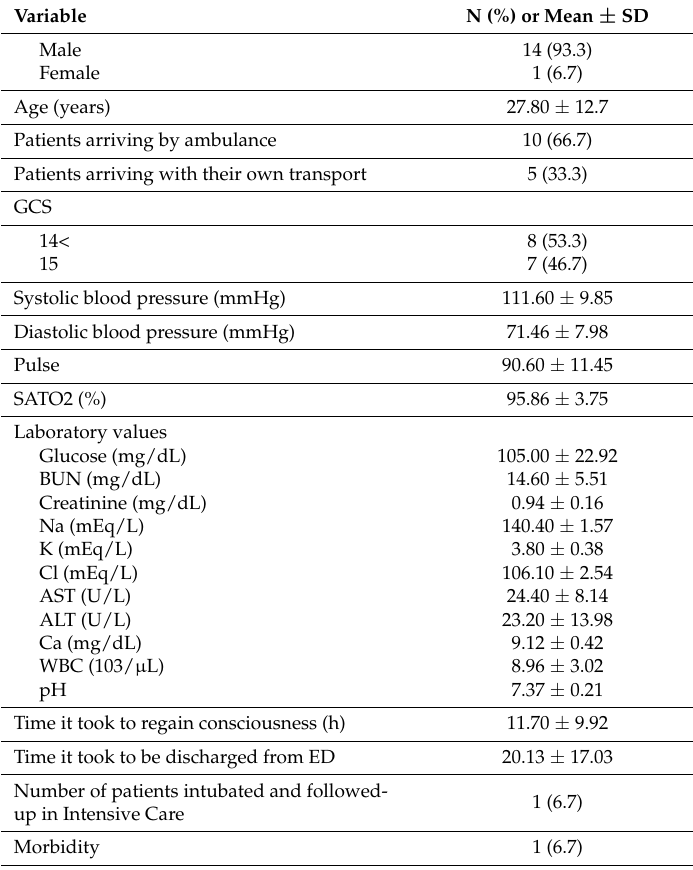
Table 1. Characteristics of the